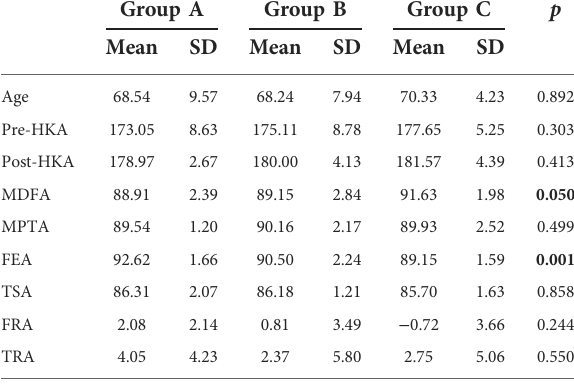
TABLE 5 The results of the Kruskal-Wallis test between different groups.